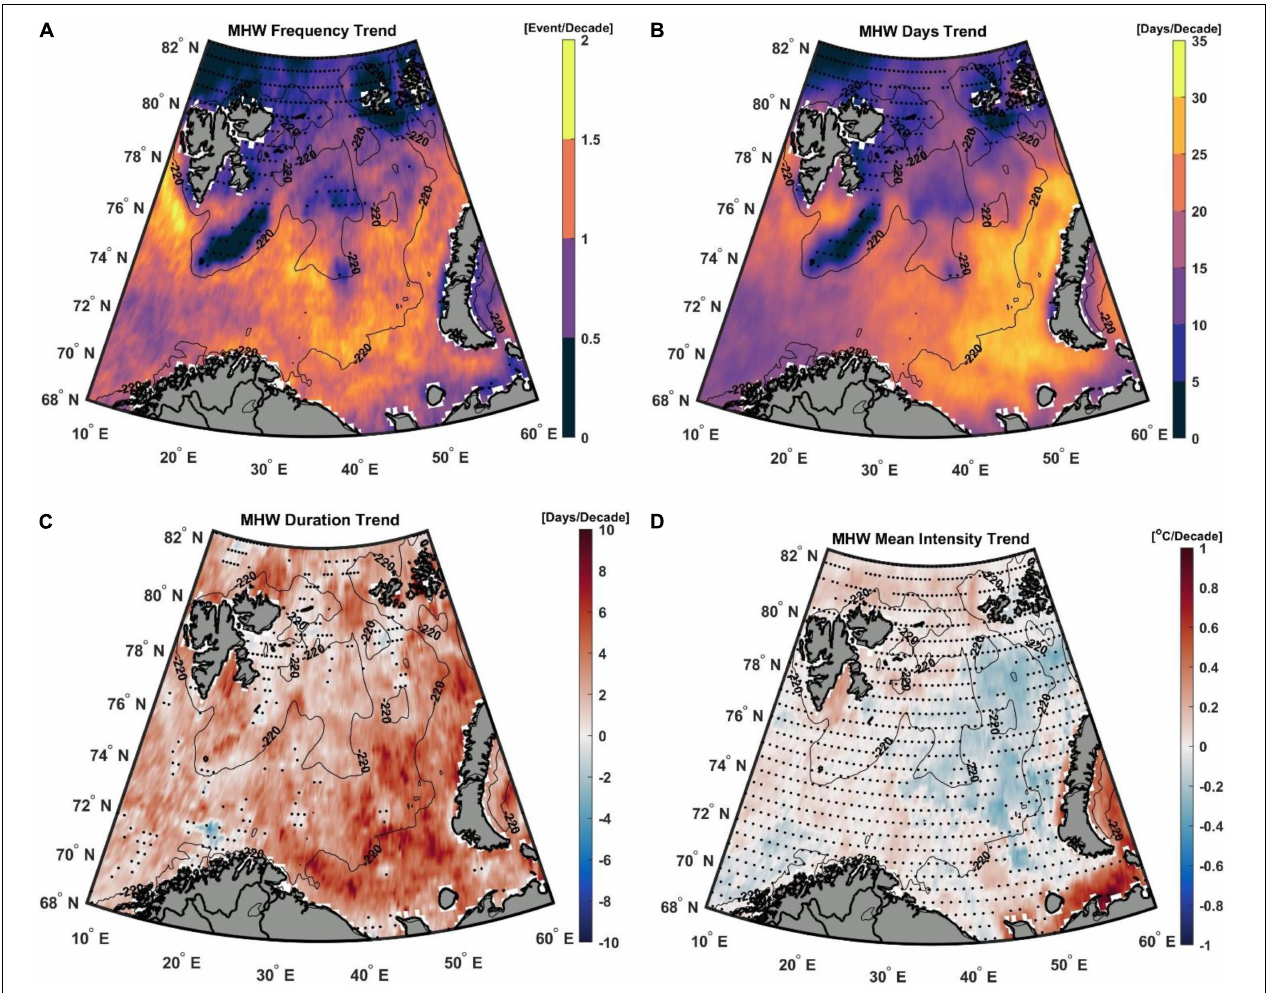
FIGURE 5 | Decadal trends in marine heatwave characteristics in the Barents Sea over the period 1982–2020 with (A) MHW frequency (events/decade), (B) MHW days (days/decade), (C) MHW duration (days/decade), and (D) MHW mean intensity ( ◦ C/decade). Stippled regions indicate that the trend is statistically non-significant at the 95% confidence interval ( p >